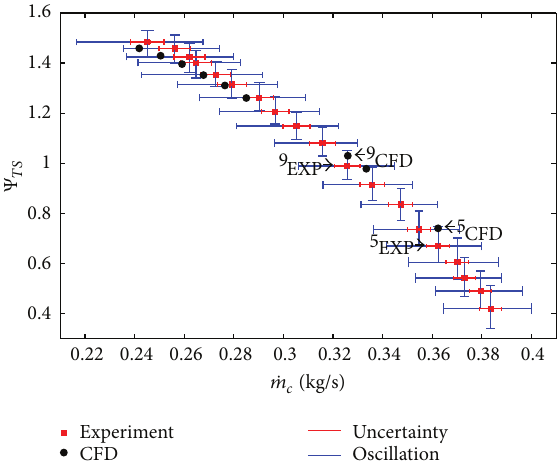
Figure 7: Measured versus computational stagnation-to-static pres- sure rise characteristic for the axial stage.